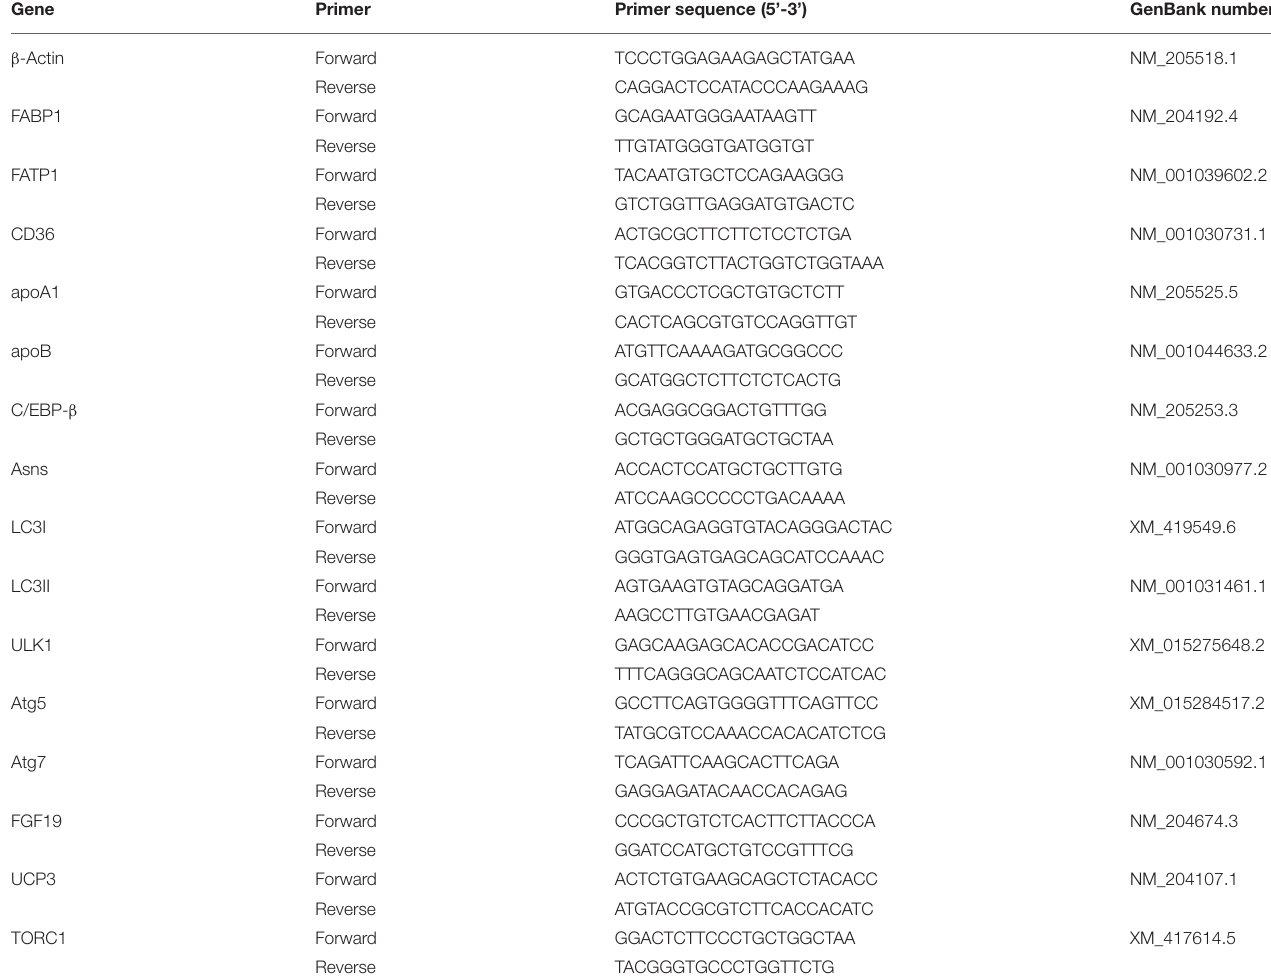
TABLE 2 | Primers used for quantitative real-time PCR. Gene